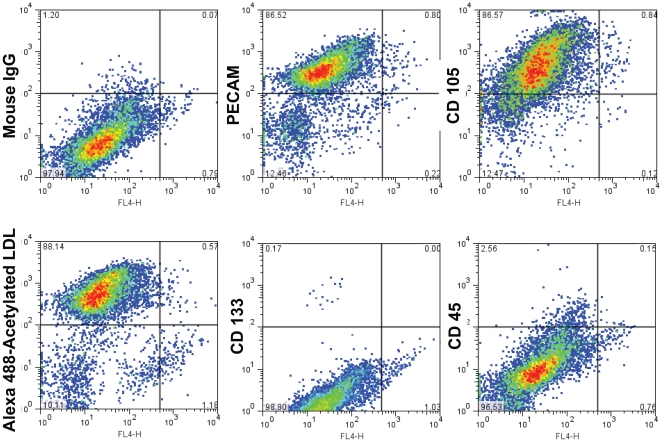
Flow cytometry analysis of porcine late outgrowth endothelial progenitor cells (LOEPCs).Representative flow cytometry plots of cultured late outgrowth endothelial progenitor cells expanded from initial clonal outgrowths from blood mononuclear cells. LOEPCs were analyzed with mouse monoclonal antibodies to the following antigens: Mouse IgG1, Mouse anti-pig CD31, CD105, CD133, and CD45. Primary antibodies were detected with Alexa Fluor 488 conjugated donkey anti-mouse antibodies. Results are representative of at least three independent experiments from separate animals.